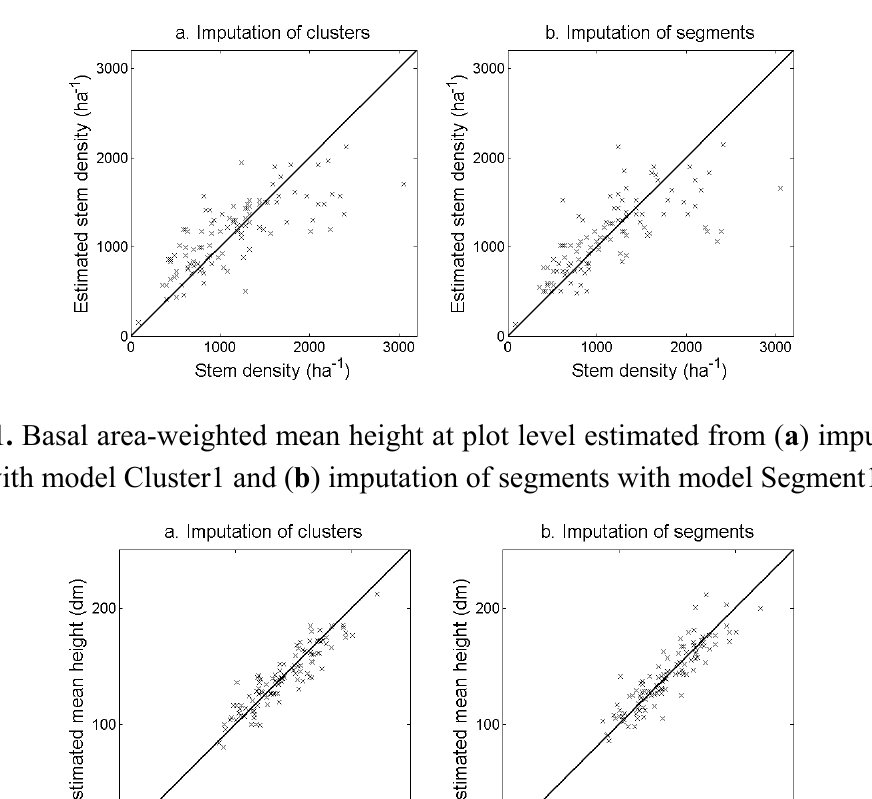
Figure 10. Stem density at plot level estimated from ( a ) imputation of clusters with model Cluster1 and ( b ) imputation of segments with model Segment1.